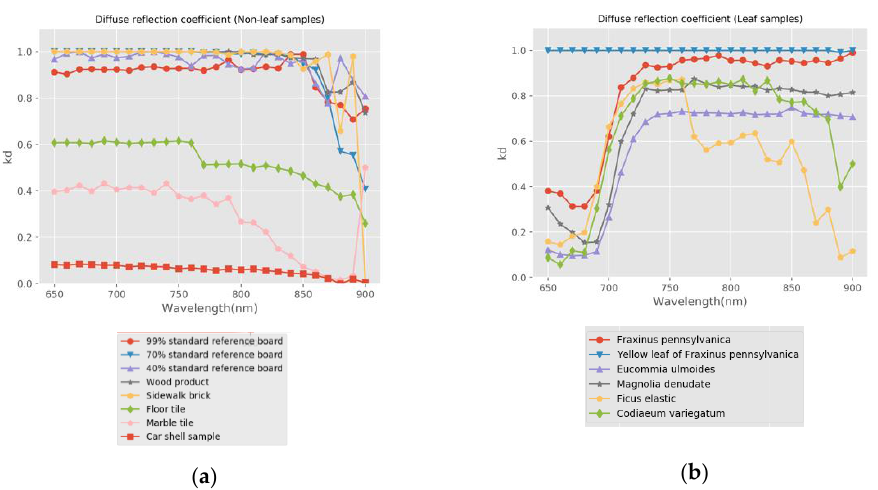
Figure 7. The relationship between diffuse reflection coefficient, k d , and wavelength, λ . ( a ) Non-leaf samples; ( b ) Leaf